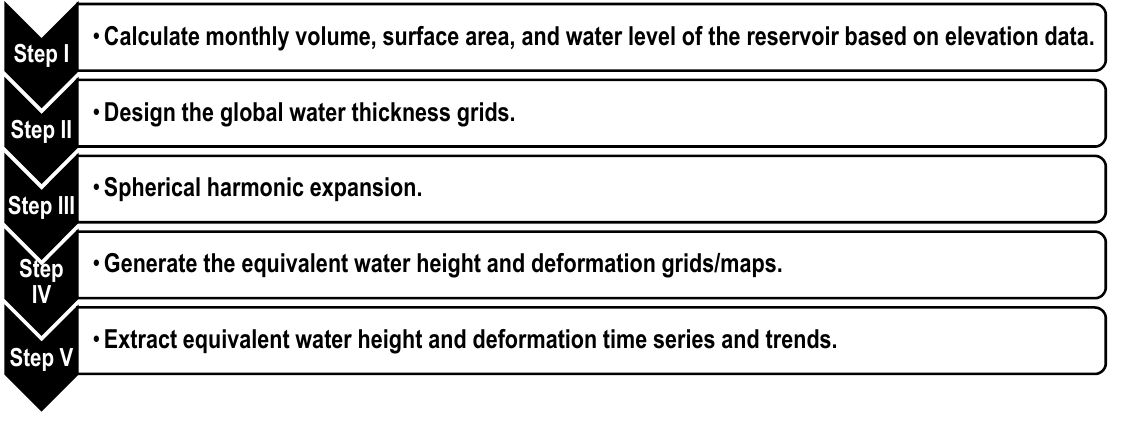
Figure 2. Data processing steps used in this study.